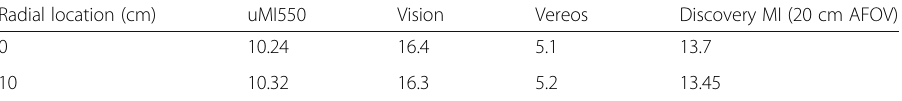
Table 4 A comparison of sensitivity performance among different scanner models. unit: cps/kBq Radial location (cm)